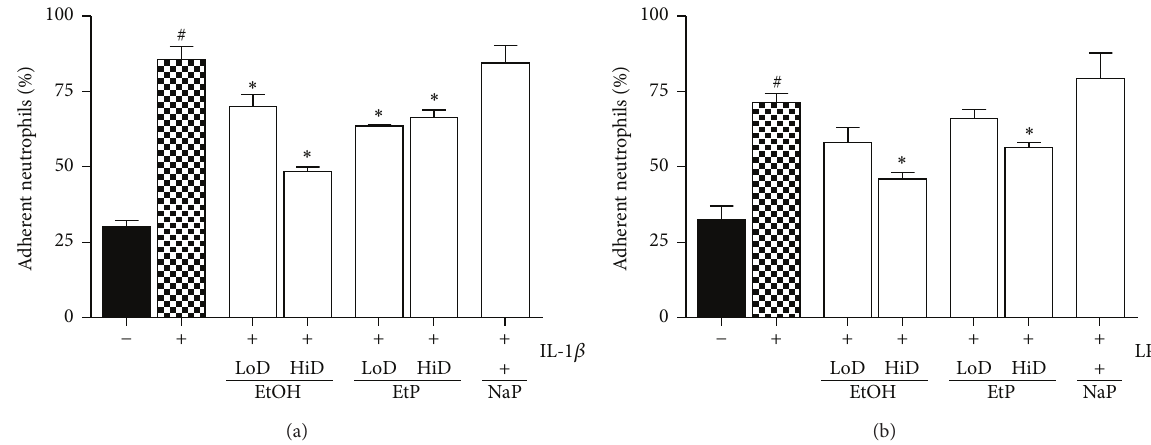
Figure 9: Effects of ethanol (EtOH), ethyl pyruvate (EtP), or sodium pyruvate (NaP) on the adhesiveness of neutrophils to lung epithelial cells A549 after IL-1beta (a) or lipopolysaccharide (LPS) stimulation. Cells were treated with EtOH (low dose, LoD = 85 mM and high dose, HiD = 170 mM), EtP (LoD = 2.5 mM and HiD = 10mM), or NaP (10mM) for 1h and then stimulated with IL-1beta (1ng/mL) or LPS (1 𝜇 g/mL) for 24 h. After the incubation periods, neutrophils were added and the adhesion capacity after 30 minutes was analyzed (given as % of total neutrophils). The data are presented as means ± s.e.m. ∗ 𝑃 < 0.05 versus untreated but stimulated control, ctrl; # 𝑃 < 0.05 versus untreated and unstimulated